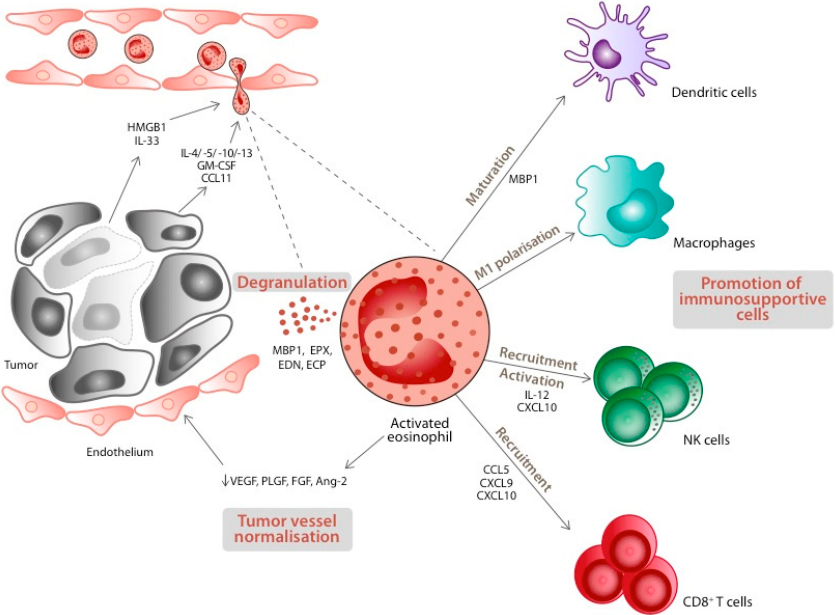
Figure 3. Eosinophil recruitment at tumor sites and anti-tumor effects of eosinophils. In response to their recruitment and activation via different cytokines and chemokines such as tumor-secreted Interleukin-5 (IL-5), or IL-33 and High Mobility Group Box-1 protein (HMGB-1), alarmins secreted by dying tumor cells, eosinophils display both direct and indirect anti-tumorigenic effects. Degranulation of eosinophils has cytotoxic and ribonucleasic effects. Moroever, activated eosinophils are capable of recruiting immune cells to engage against tumors: Natural Killer (NK) cells, cytotoxic CD8 + T cells, and dendritic cells (DC). Additionally, they can polarise macrophages to an M1, anti-tumorigenic phenotype. Finally, eosinophils appear to affect tumor vasculature by increasing vascular leakiness, leading to tumor necrosis. IL: Interleukin; HMGB-1: High Mobility Group Box-1 protein; PRR: Pattern Recognition Receptor; CCL11: CC-chemokine ligand 11 = eotaxin1; CXCL9: CXC-chemokine ligand 9; MBP-1: major basic protein-1; EPX: eosinophil peroxidase; EDN: eosinophil-derived neurotoxin; ECP: eosinophil cationic protein; ↓ : reduced expression; VEGF: vascular endothelial growth factor; PLGF: platelet growth factor; FGF: fibroblast growth factor; Ang-2: angiopoietin-2.